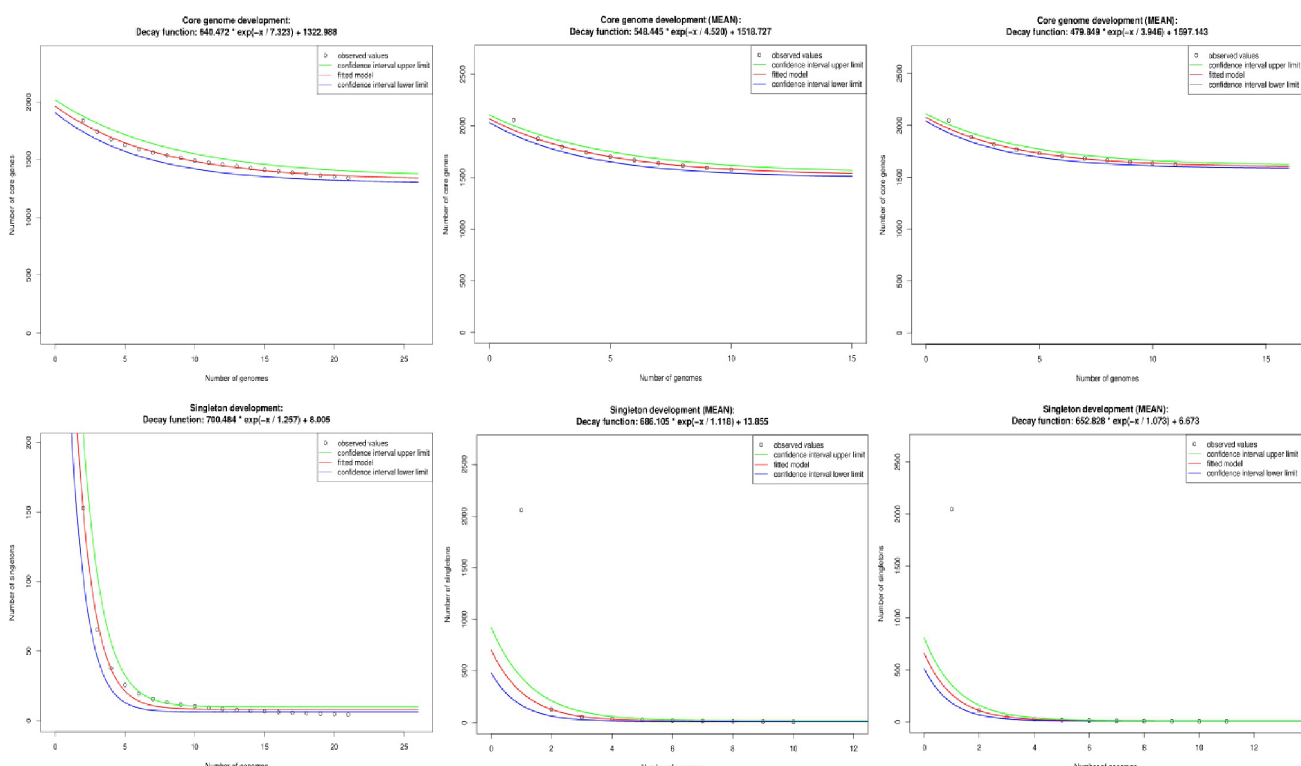
Fig 6. C . bovis’ core genome and singleton development. The core genome development using permutations of all 21 isolates of C . bovis (upper left); the core genome development of the C . bovis isolates obtained from humans and cattle (upper-center); the core genome development of the C . bovis isolates obtained from rodents (mice and a rat) (upper-right); the singleton using permutations of all 21 isolates of C . bovis (lower left); the singleton development of the C . bovis isolates obtained from humans and cattle (lower-center); and, the singleton development of the C . bovis isolates obtained from rodents (mice and a rat) upper-right).